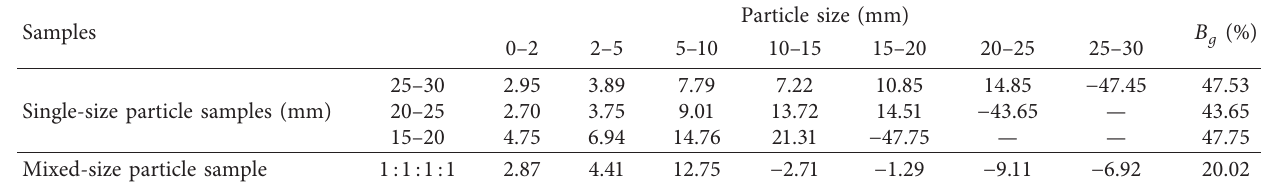
Table 3: The particle breakage for samples with different particle size and gradation. Samples